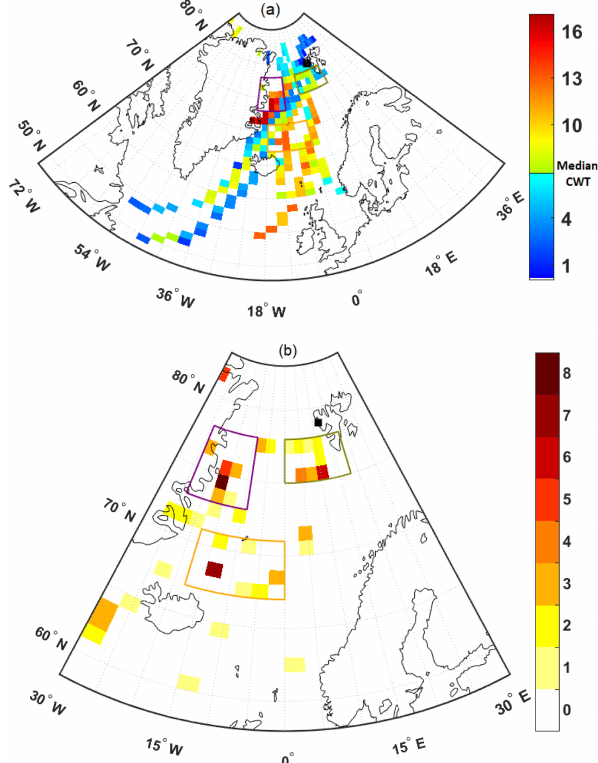
Figure 8. (a) CWT source map for the n INP PM at T = − 15 ◦ C 1 dataset. The color scale indicates the CWT value. (b) Spatial dis- tribution of fine INP sources identified by merging the results of the spatiotemporal correlation analysis and of the CWT algo- rithm. The color scale reflects how many times a given pixel has a CWT ≥ median and significant correlation coefficient by running time lags from 5 to 20d. The same purple, green and orange boxes of Fig. 7 are reported to facilitate the